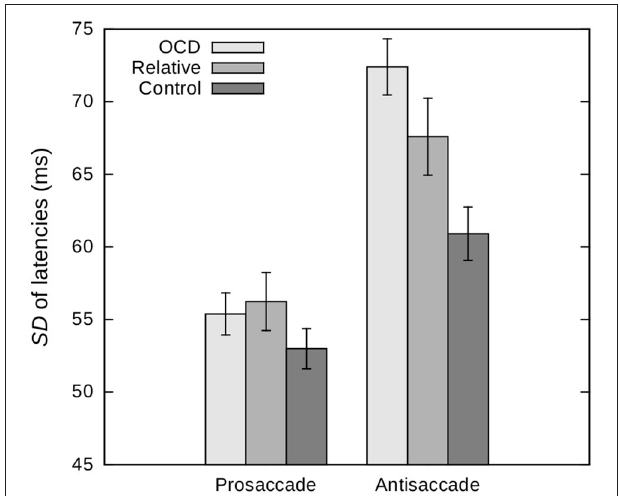
FIGURE 2 | Intra-subject variability, i.e., SD s, of pro- and antisaccade latencies in patients with obsessive-compulsive disorder (OCD), unaffected first-degree relatives and healthy control subjects. Age is included as a covariate and values are depicted for a mean age of 36.37 years. Error bars indicate standard errors. The effect of group and the group by task interaction are significant at p = 0.002 and p = 0.001,